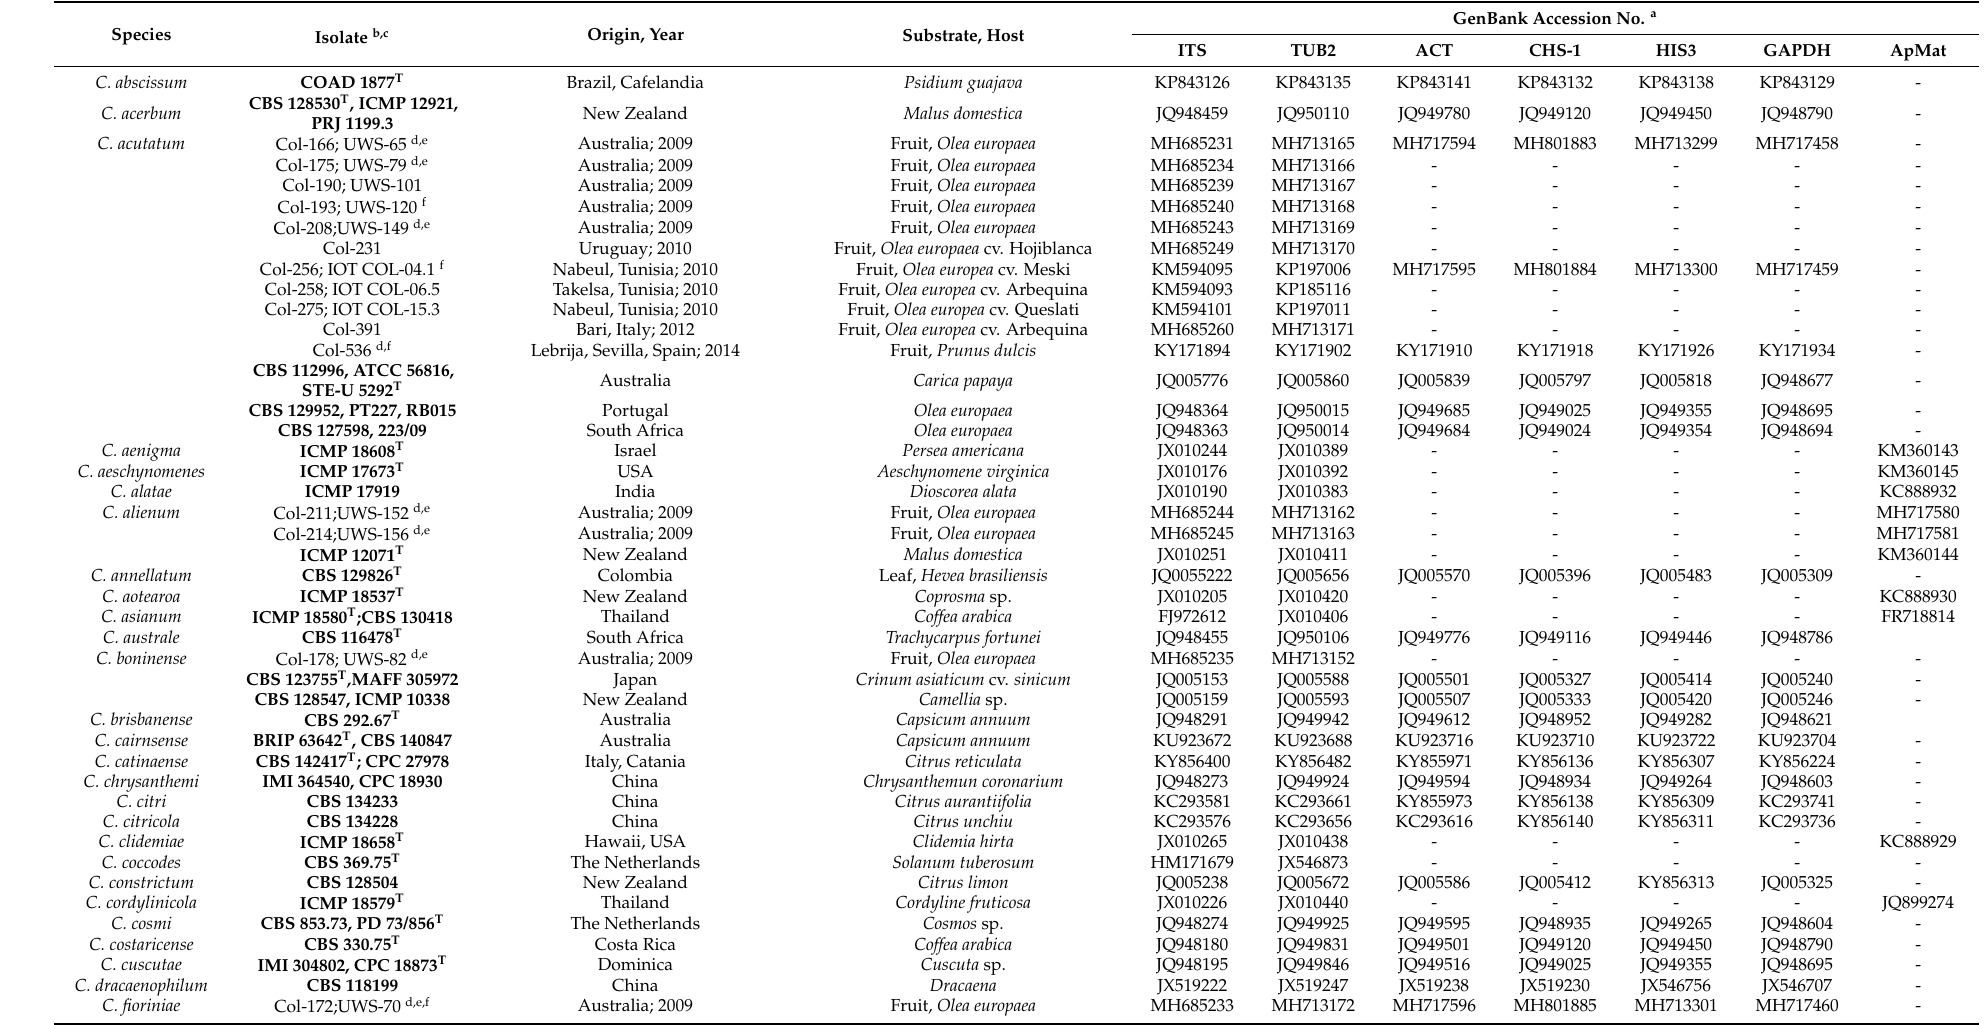
Table 1. Isolates of Colletotrichum spp. used in this study, with collection details and GenBank